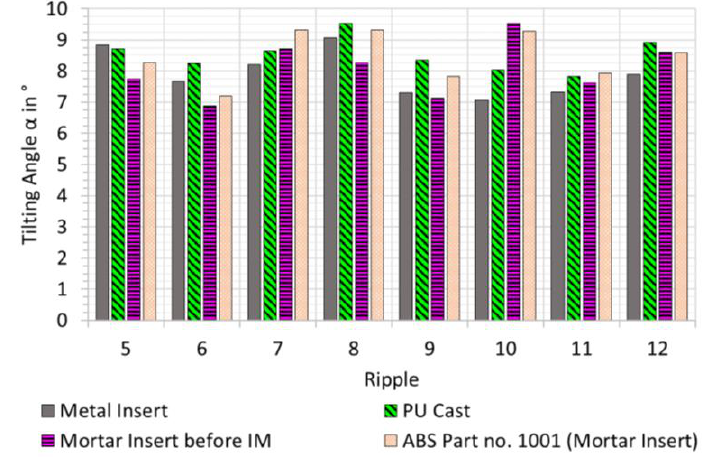
Figure 10. Tilting angle α for ripples 5 to 12 measured on metal insert, polyurethane cast (PU cast), and mortar insert, respectively, before injection moulding experiments had been performed. In addition and for comparison, the tilting angle measured on ABS part no. 1001 (moulded on mortar insert) is also included.